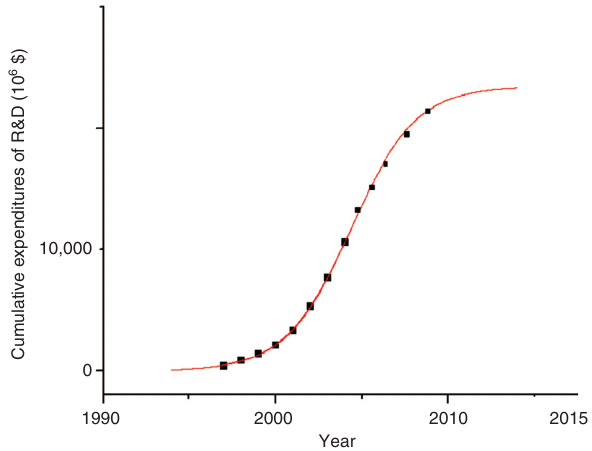
Figure 2 Extraction of the S-curve for the evolution of spending in R&D in nanotechnology, based on the data extracted from Figure 1 and also given in the